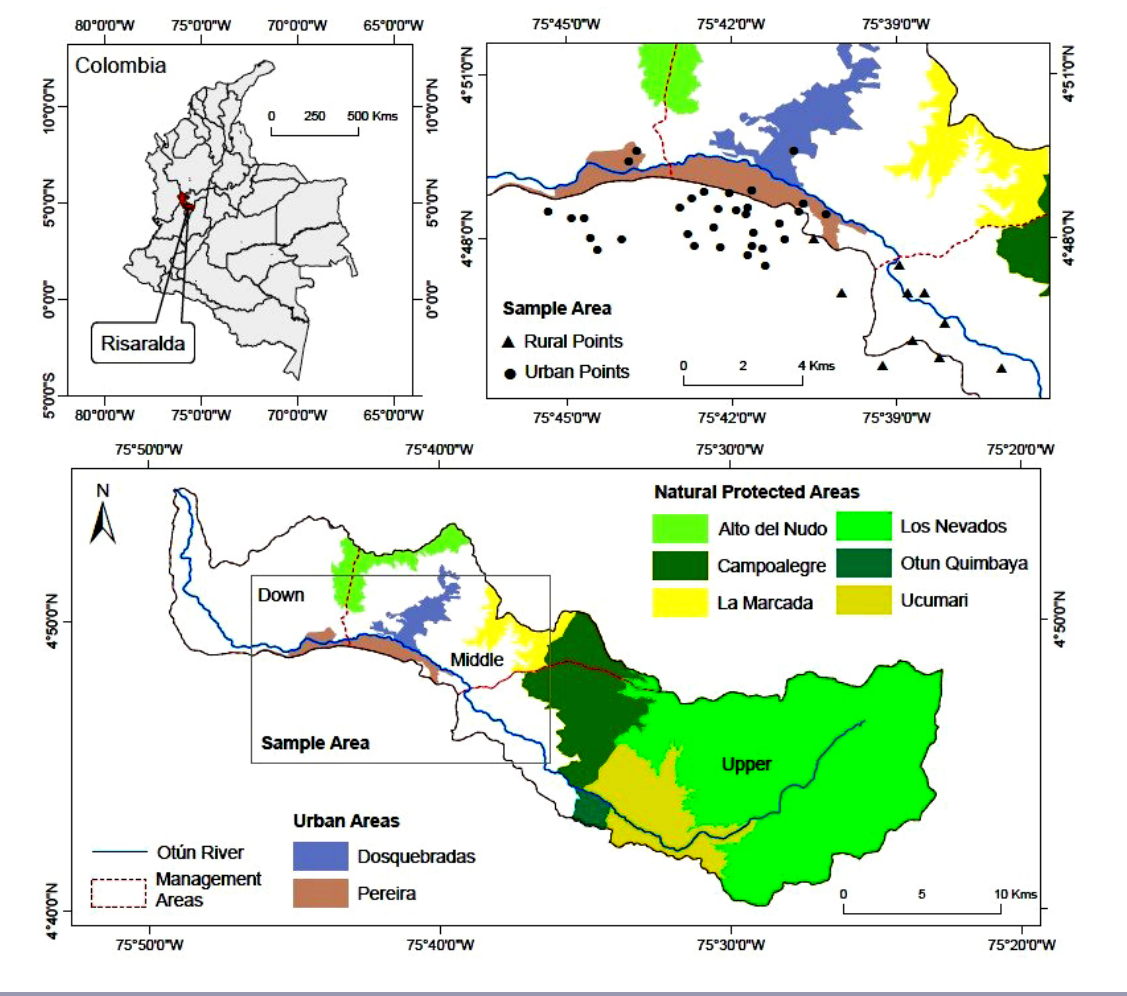
Fig. 2. Maps of the study area and sampling